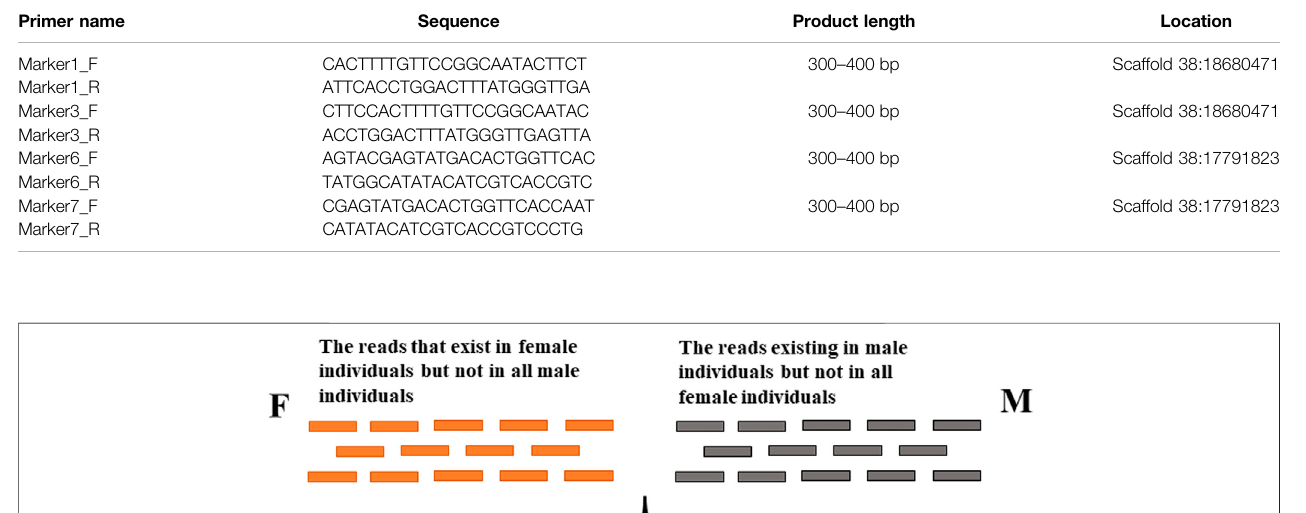
TABLE 1 | Primers for developing PCR-based sex-speci fi c molecular markers.